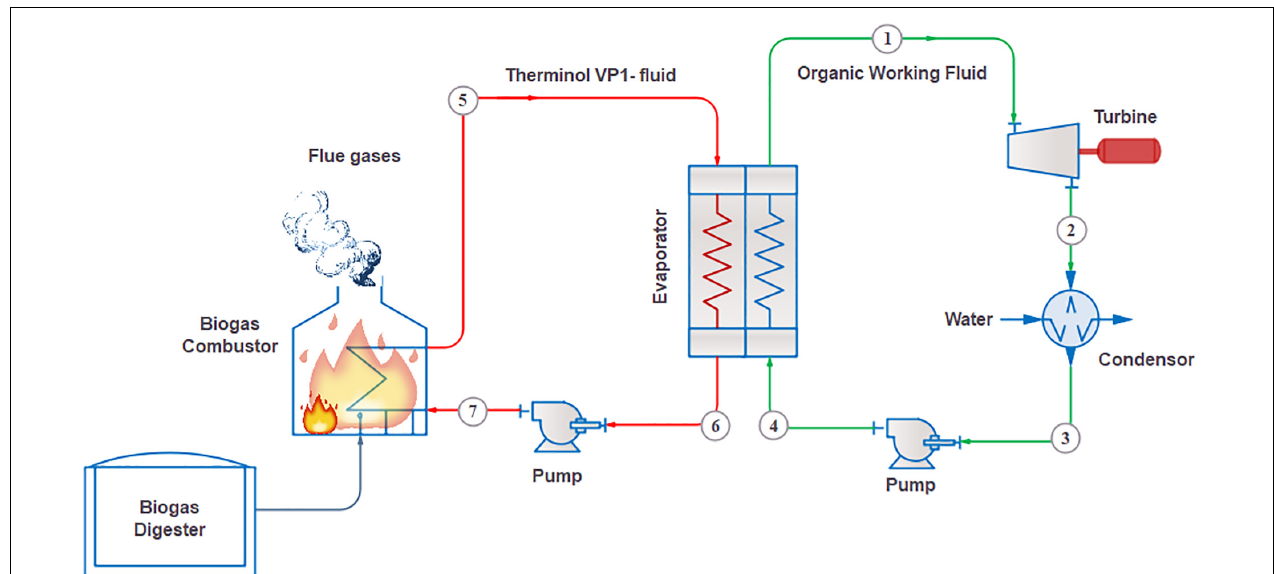
FIGURE 1 | Schematic diagram of biogas-fueled organic Rankine cycle (ORC) system for power generation.